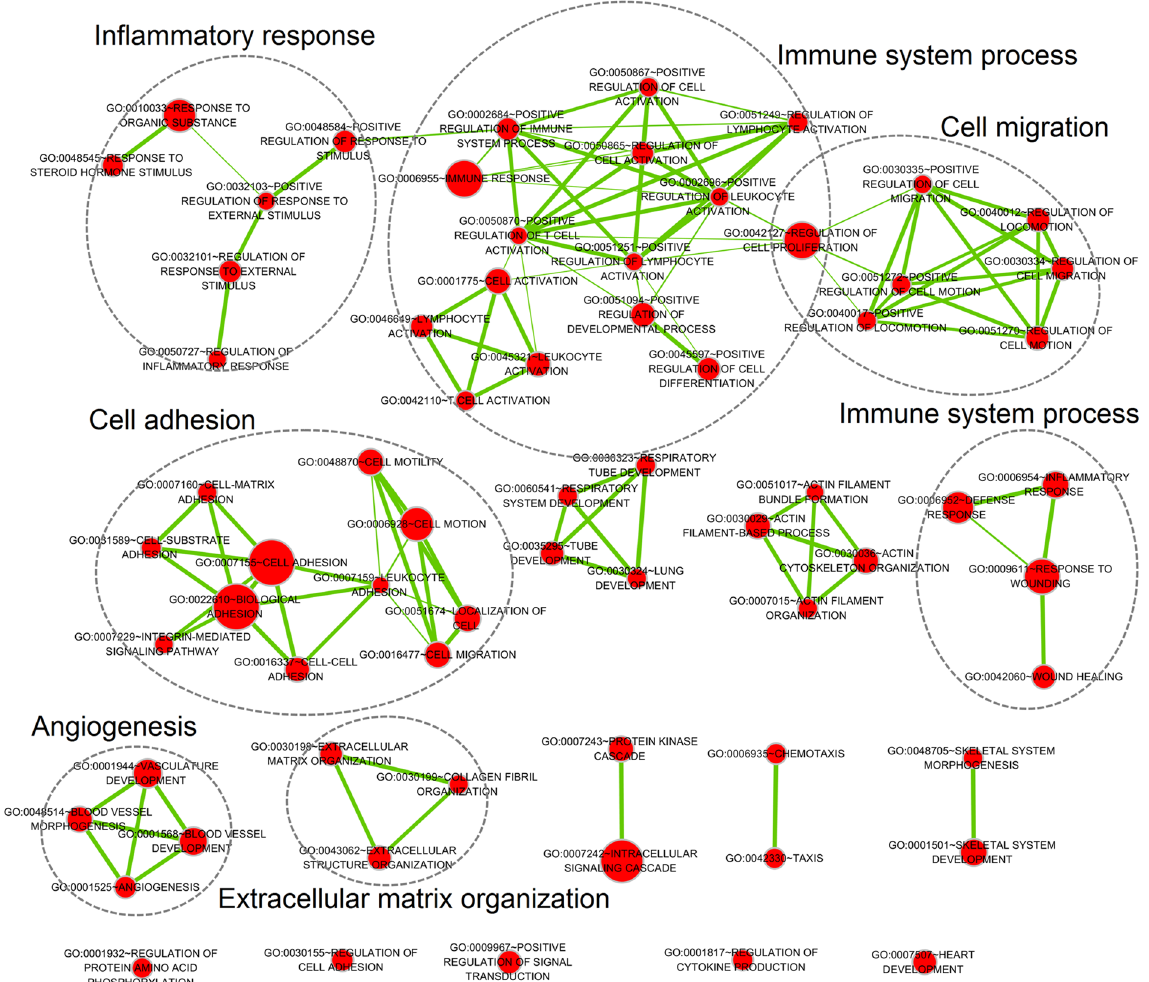
Figure 5. Interaction network of significant GO biological process terms with similar functions associated with six lncRNAs. Red nodes represent GO biological process terms. Node size is proportional to the total number of DEGs in that term. Thickness of green lines is proportional to the shared DEGs of two connected